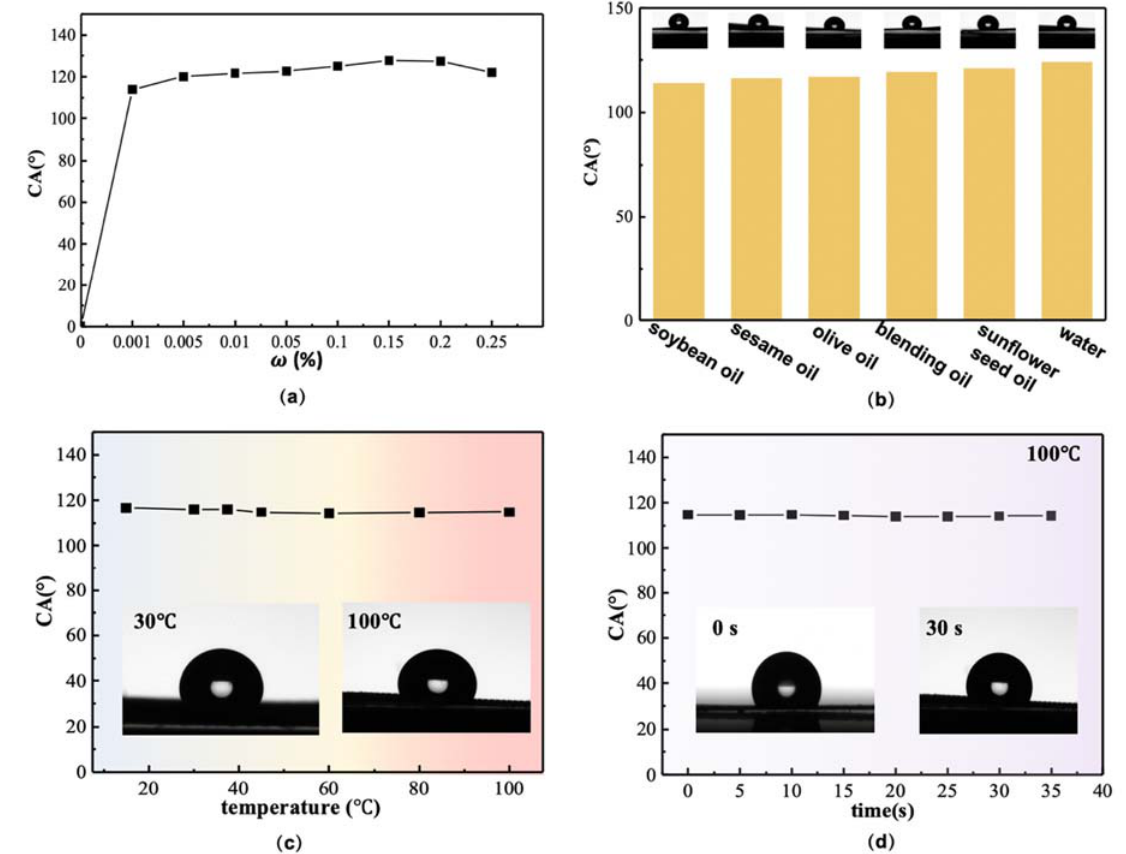
Figure 2. The oleophobic effect of the SPFO coating under different conditions. The oil contact angles of SPFO ‐ coated PVDF fibre membranes with ( a ) different SPFO concentrations and ( b ) different oils. The oil contact angles of SPFO ‐ coated stainless steel mesh at ( c ) different temperatures of 30 and 100 °C and ( d ) with increasing exposure time at 100 °C.